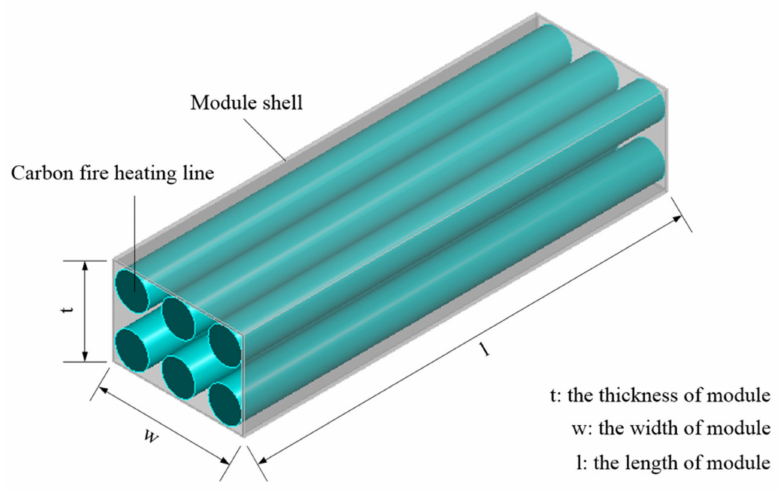
Figure 14. Heating module